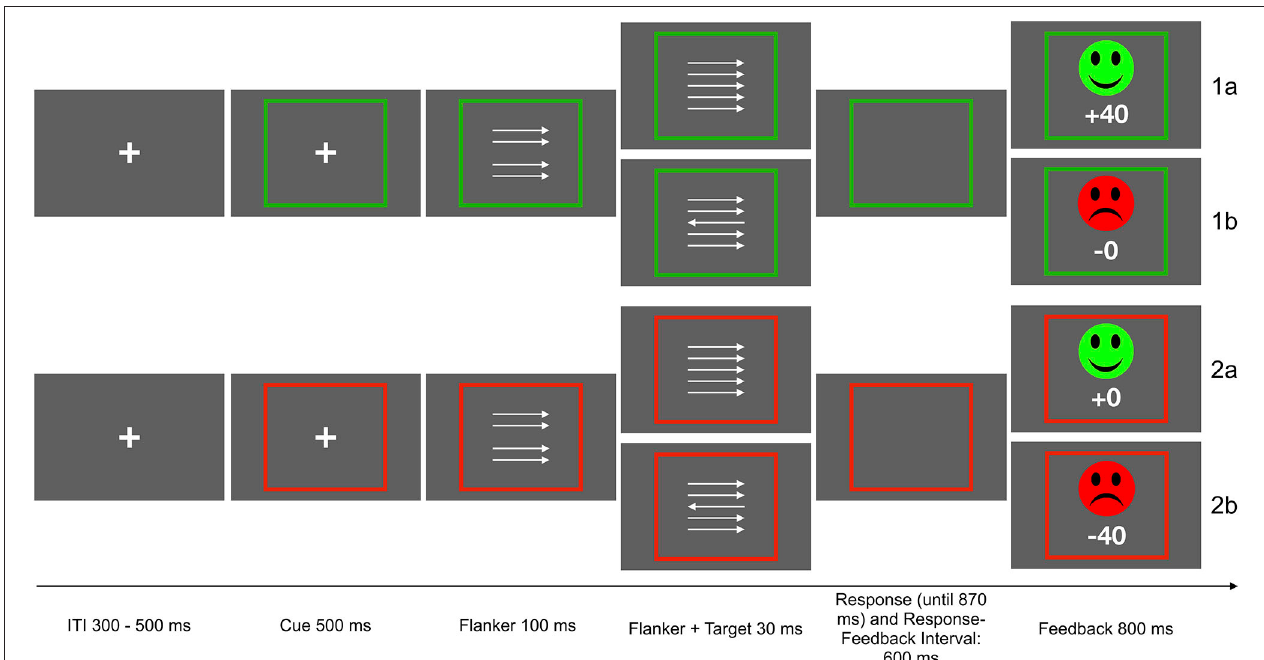
FIGURE 1 | Schematic depiction of the flanker task. Participants were instructed to respond with the left or right button according to the direction of the middle arrow. In the gain context, the fastest 20% of the correct response were rewarded (1a), in the loss avoidance context incorrect and slowest responses were punished (2b). The other responses were neither punished nor rewarded (1b,